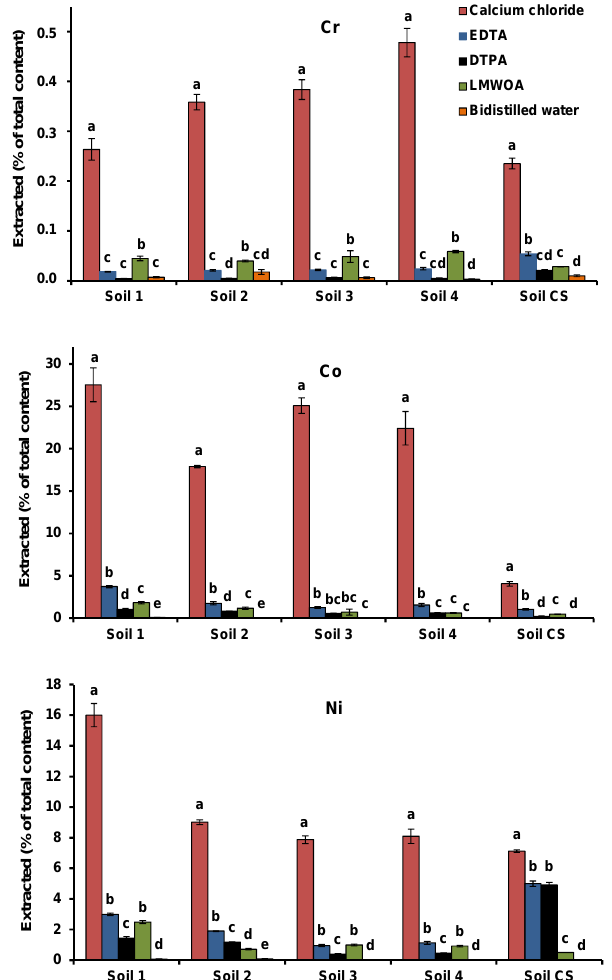
Figure 2. Extraction efficiency. In each soil, bars with different let- ters indicate significantly different EF values ( p < 0.05) for each metal. Hanging bars are the standard